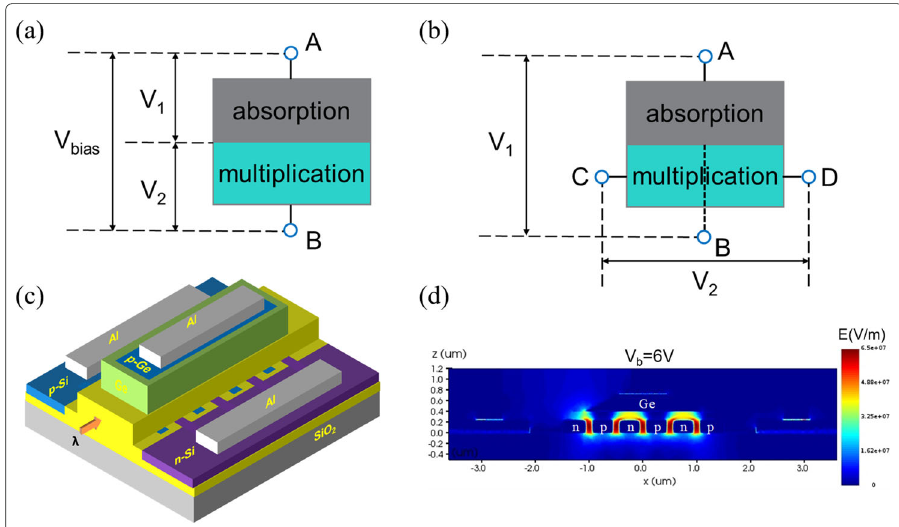
Fig. 8 Simplified schematics of a two-termimal and b three-terminal Si-Ge APDs; c Schematic and d electric field distribution of the three-terminal waveguide-coupled Si-Ge SACM APD